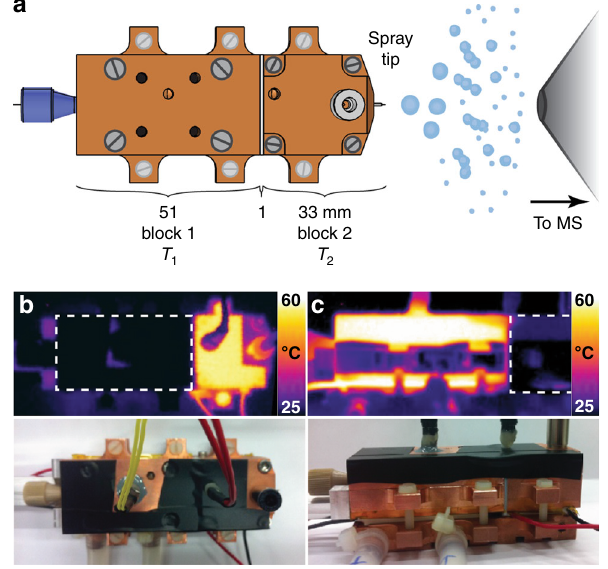
Fig. 1 Experimental setup. a Schematic representation of the temperature- jump electrospray source. b , c Infrared pictures of the source with blocks 1 and 2 maintained at 60 and 25 °C and the reverse. The bottom pictures show the source in similar positions. To obtain the IR pictures, black tape was placed on the source in order to enhance blackbody emission and to reduce the re fl ection of light coming from other